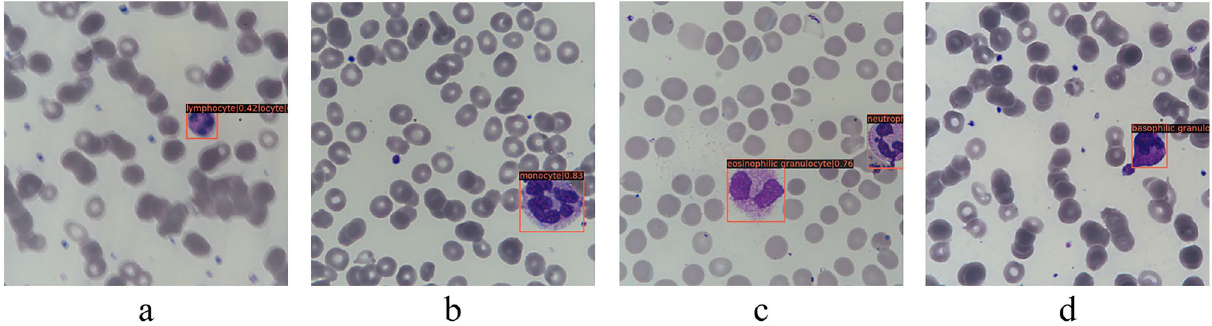
Figure 7. Some examples of partial neutrophils misidentified by the ensemble model. ( a )–( d ) The neutrophils were misidentified separately as lymphocyte, monocyte, eosinophil, and basophil.